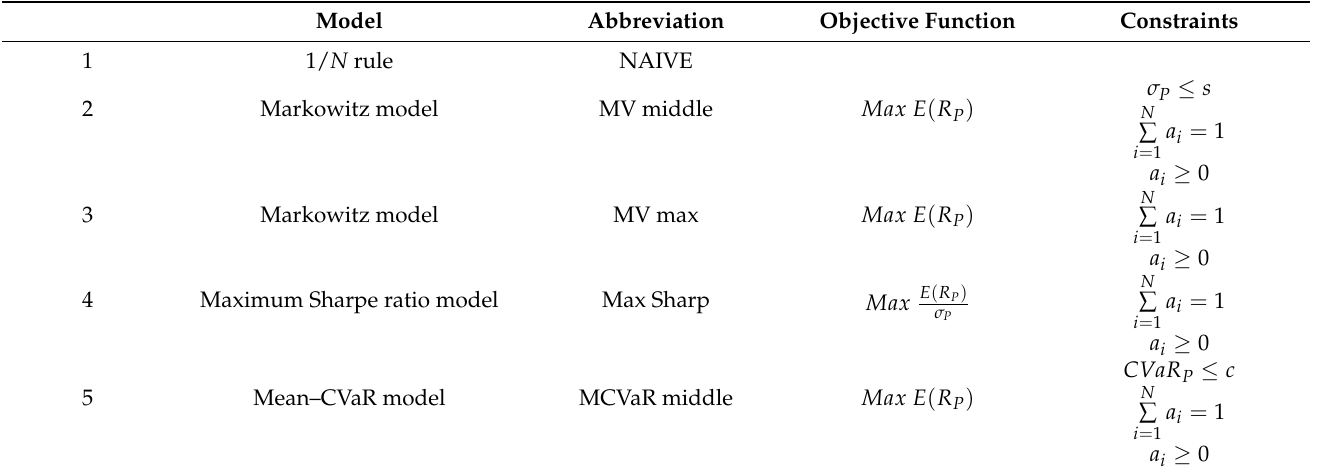
Table 5. Five portfolio optimization models.